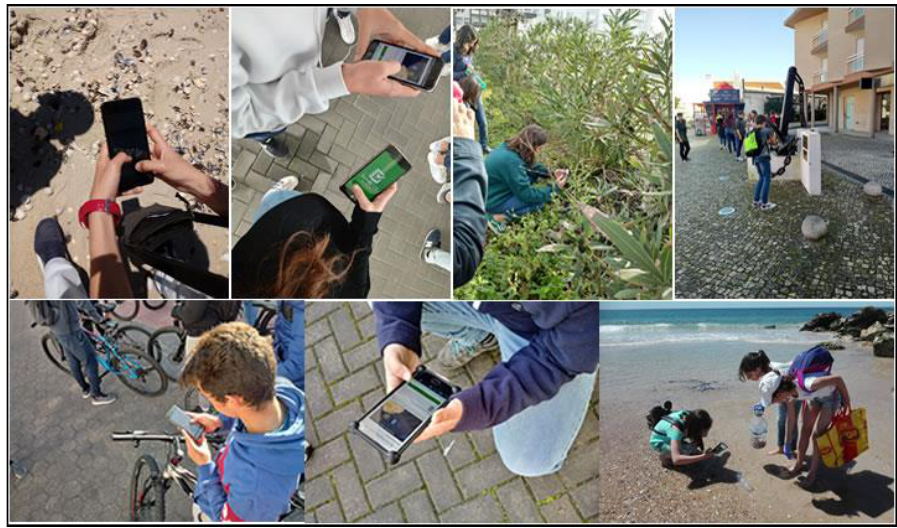
Figure 8. Students gathering data with Survey123.